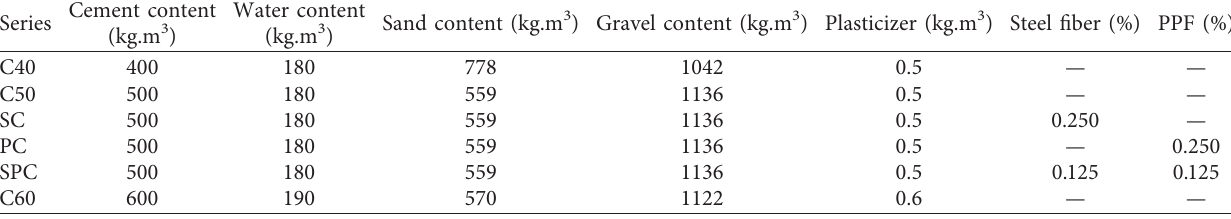
Table 2: Concrete mix proportion.